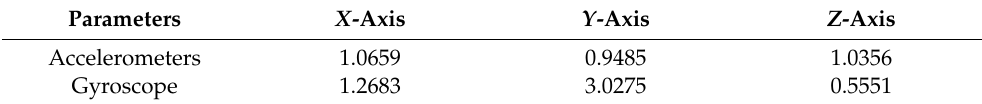
Table 4. Calibration factors for MEMS0 accelerometers and gyro-sensitive axes.